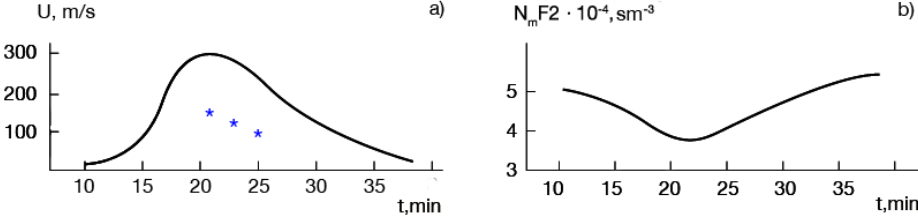
Figure 3. ( a ) Wave disturbance at a height of F 2, the ionosphere layer maximum (the stars mark the results of [13]). ( b ) Variation N m F 2 in the ionosphere during the passage of a